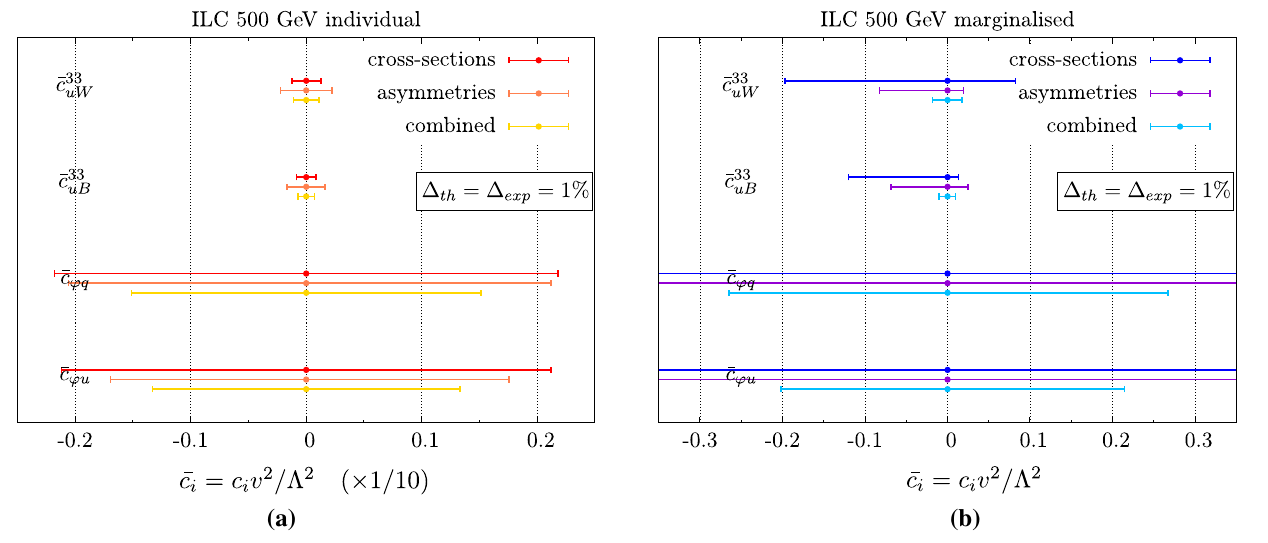
each operator considered individually ( a ) or in a 5D fit ( b ). To display both on the same plot, we scale the individual constraints up by a factor of 10, so that the bottom axis is actually ¯ c i